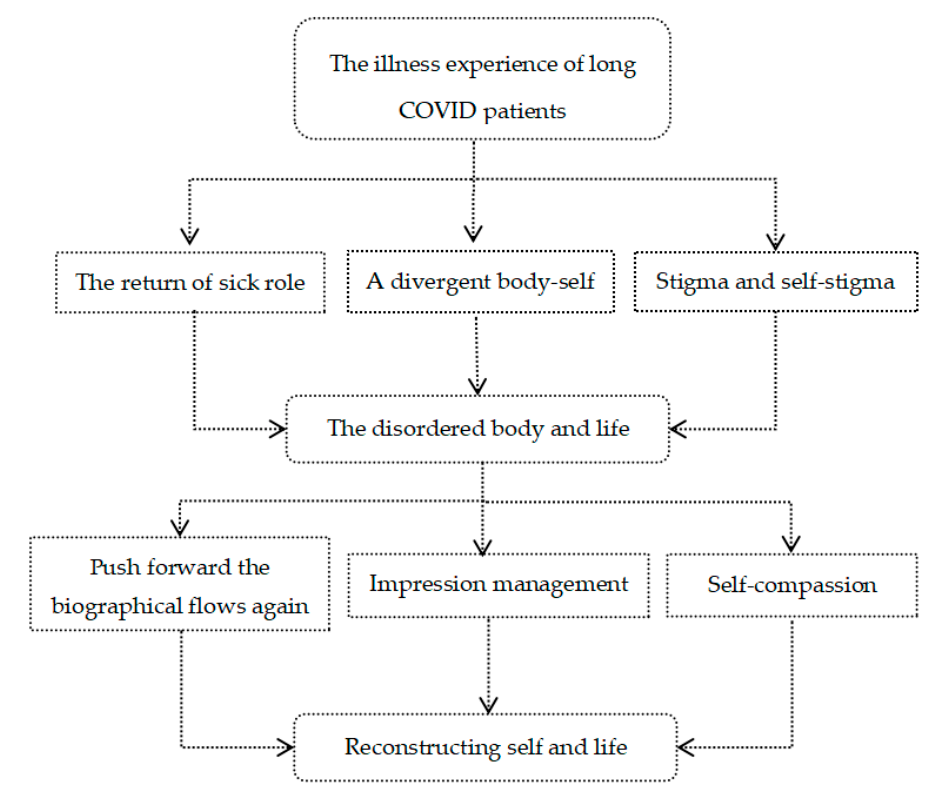
Figure 2. Text Analysis Framework.